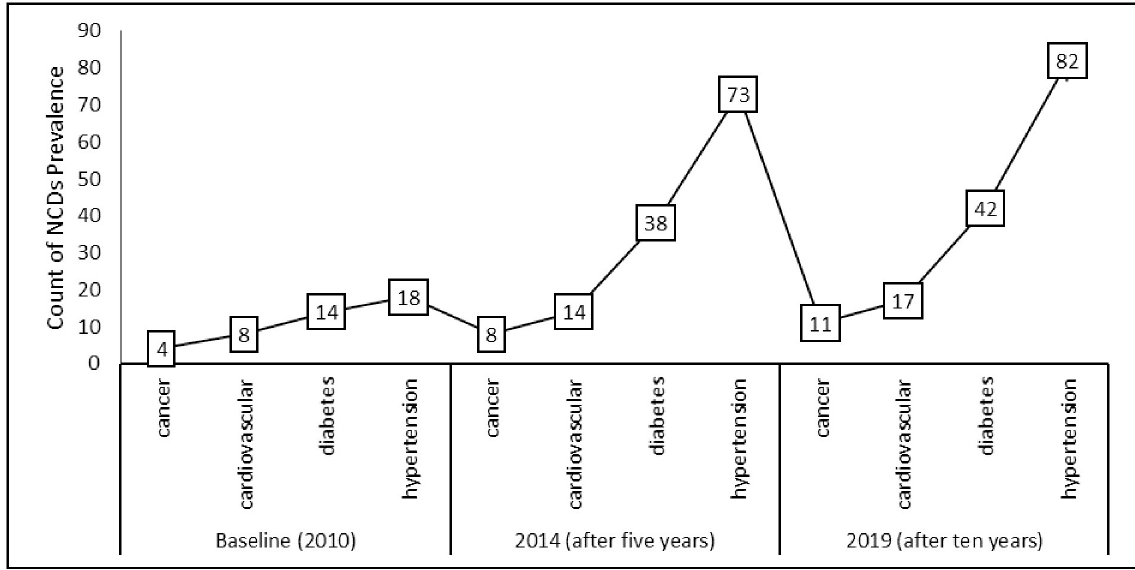
Fig 4. Prevalence of NCDs over